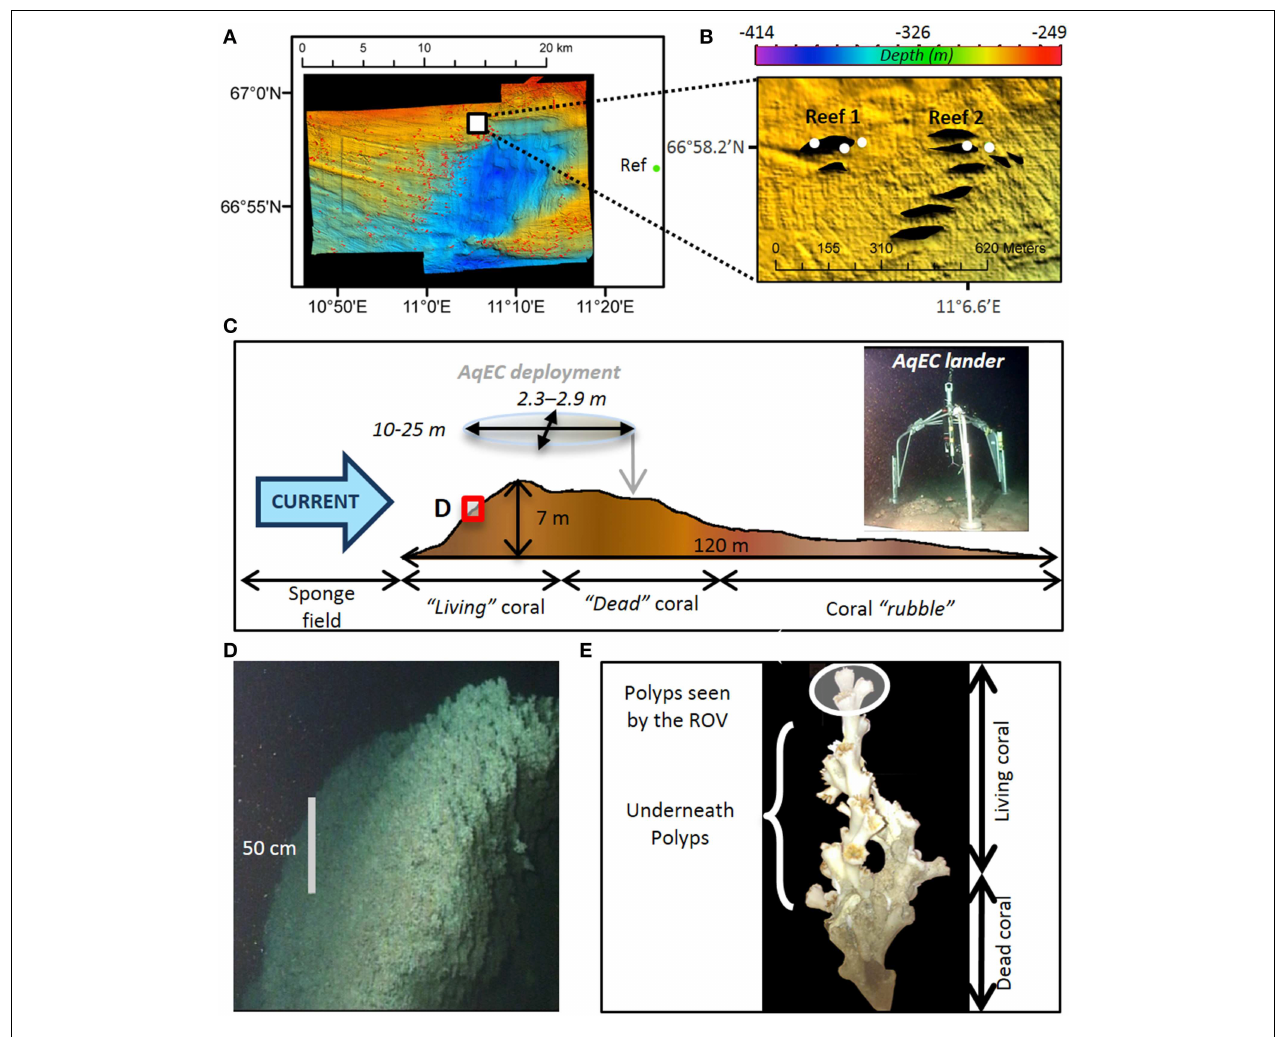
the 3D velocity components to calculate the friction velocity. (D) Photograph of a vertical lobe of densely packed branches of living Lophelia pertusa at the head of Reef R1. The exact position is indicated by the red square in (C) . (E) Coral branch sampled by ROV Aglantha. The shaded area indicates the planar view that can be “seen” by the ROV camera. The underlying layers of living and dead polyps remain hidden from the camera’s view and are indicated by the